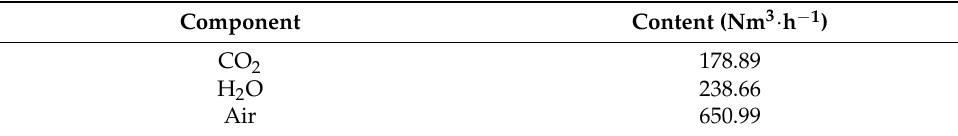
Table 3. Composition and content of exhaust gas in non-condensing steam